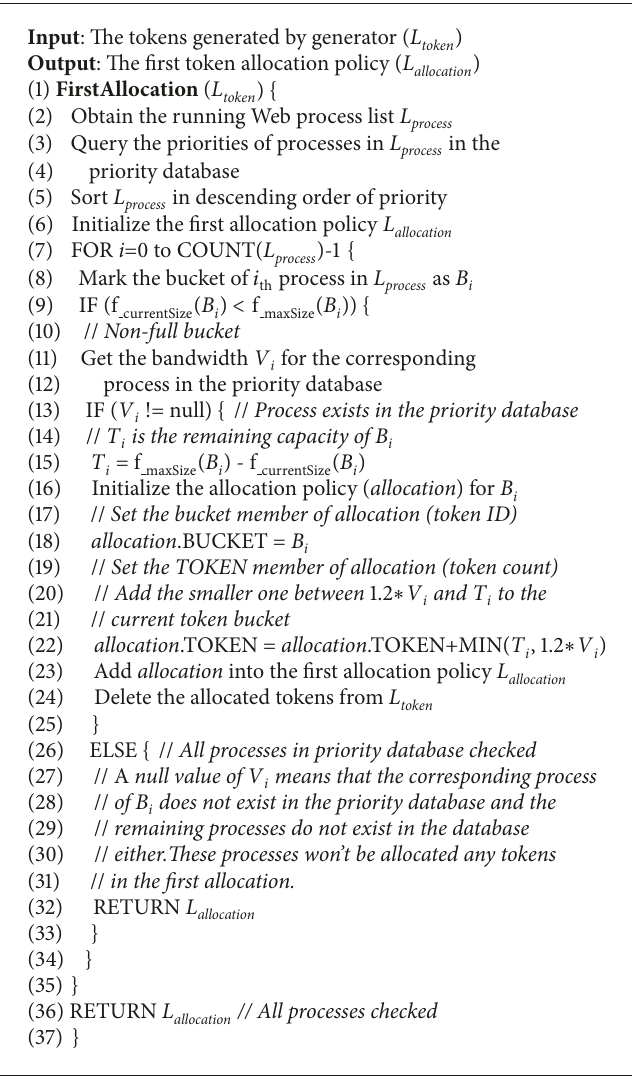
Algorithm 1: Bandwidth dynamic scheduling method (the first allocation).